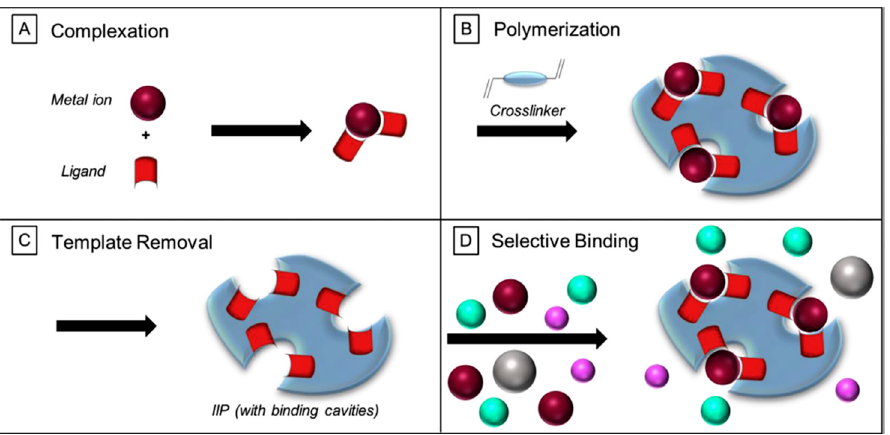
Figure 1. Schematic diagram of synthesis principle of IIP: ( A ) Complexation, ( B ) Polymerization, ( C ) Template Removal, ( D ) Selective Binding. Reprinted with permission from Ref. [24]. Copyright 2022, Elsevier.